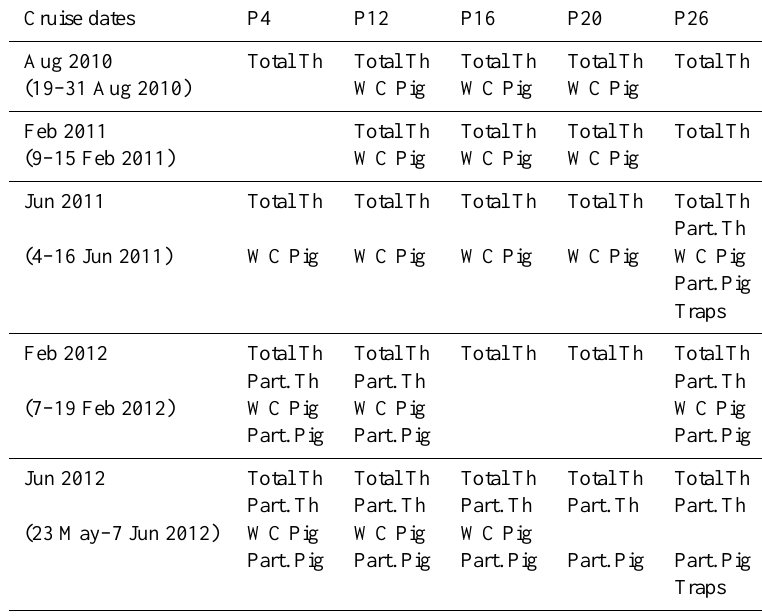
Table 2. Cruise dates and sample collection along Line P. Stations where total 234 Th (Total Th), particulate thorium (Part. Th), water column pigments (WC Pig), particulate pigments (Part. Pig), and sediment trap (Traps) were sampled are